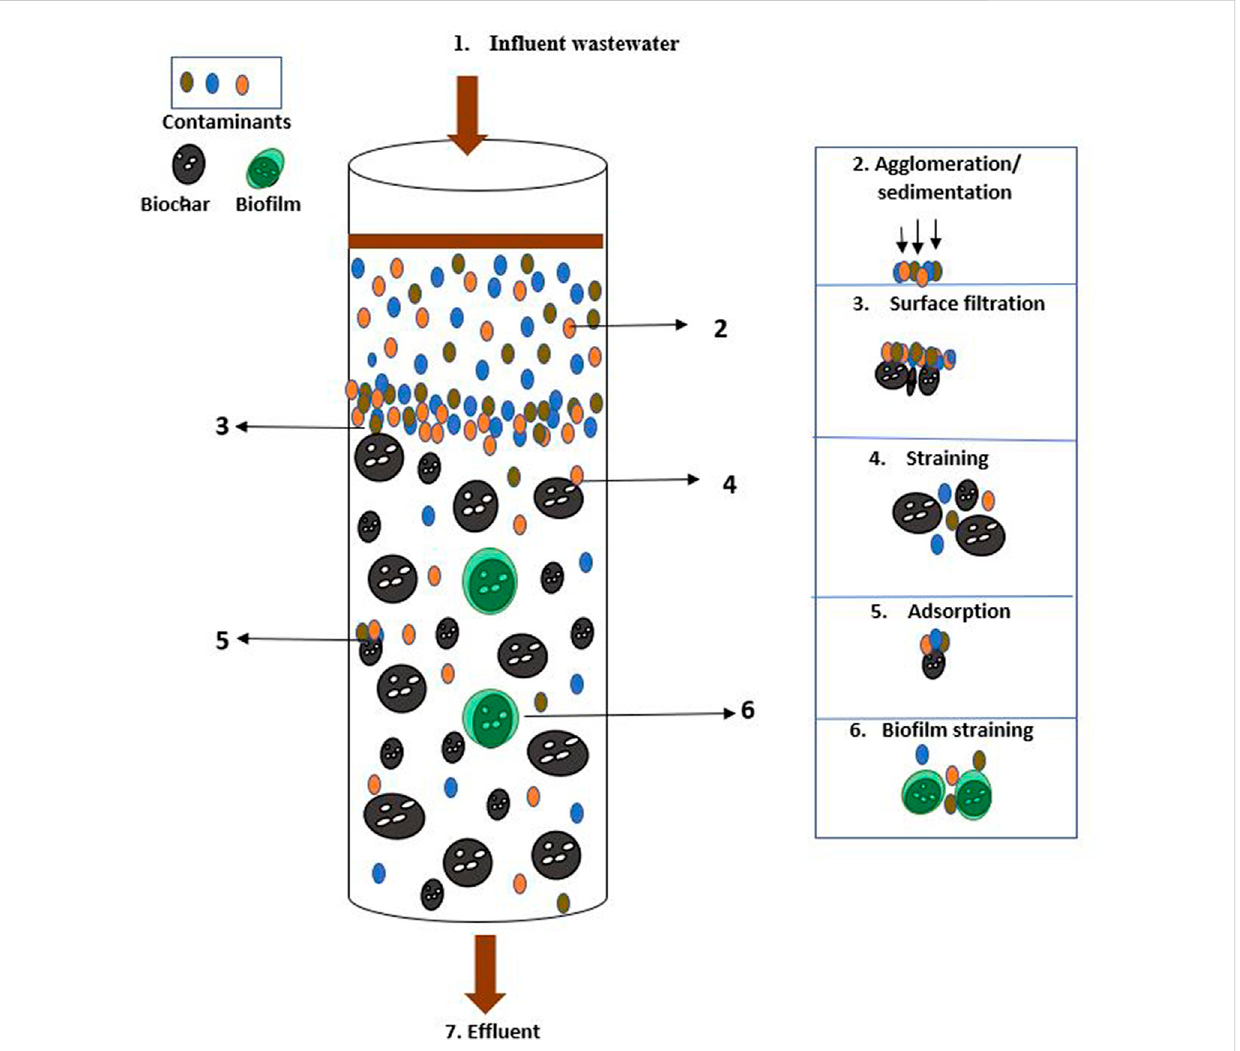
FIGURE 1 The various mechanisms through which contaminants are removed from onsite domestic wastewater by biochar (Modi fi ed from Quipse et al., 2022).